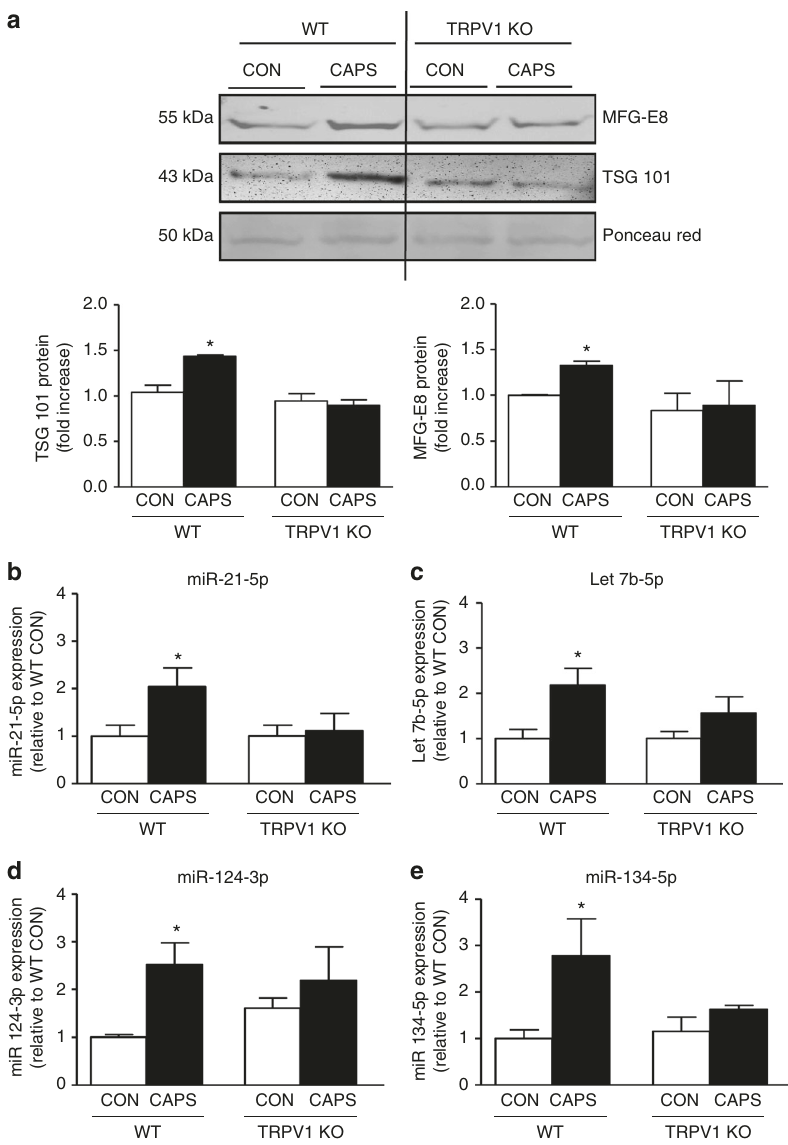
Fig. 3 Exosomes release from sensory neurons is mediated by TRPV1 activation. a Representative western blot image and quanti fi cation of exosomal markers TSG101 and MFG-E8, in the media of cultured DRG neurons obtained from WT and TRPV1 KO mice and incubated with buffer control or CAPS for 3 h. b – e Expression of miRs in exosomal fraction of DRG media obtained from WT and TRPV1 KO mice. Data are means ± S.E.M., n = 4. * P < 0.05 compared to control WT, one-way ANOVA, post hoc Bonferroni